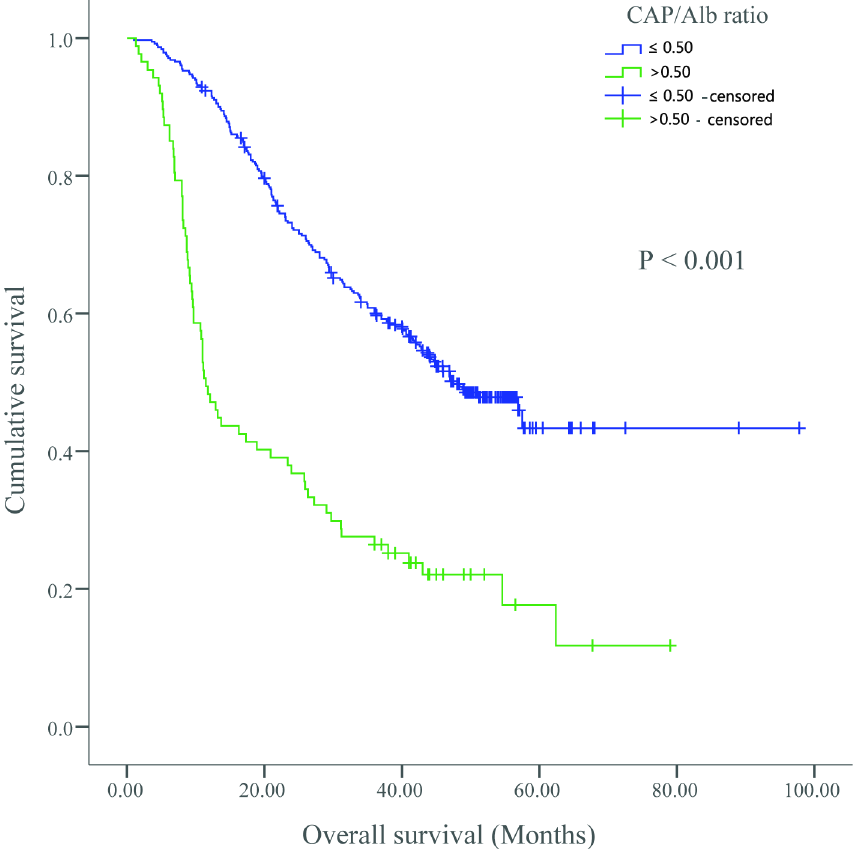
Fig 2. Kaplan – Meier curves showing the difference in OS for patients with primary operable ESCC categorized according to the optimal cutoff.